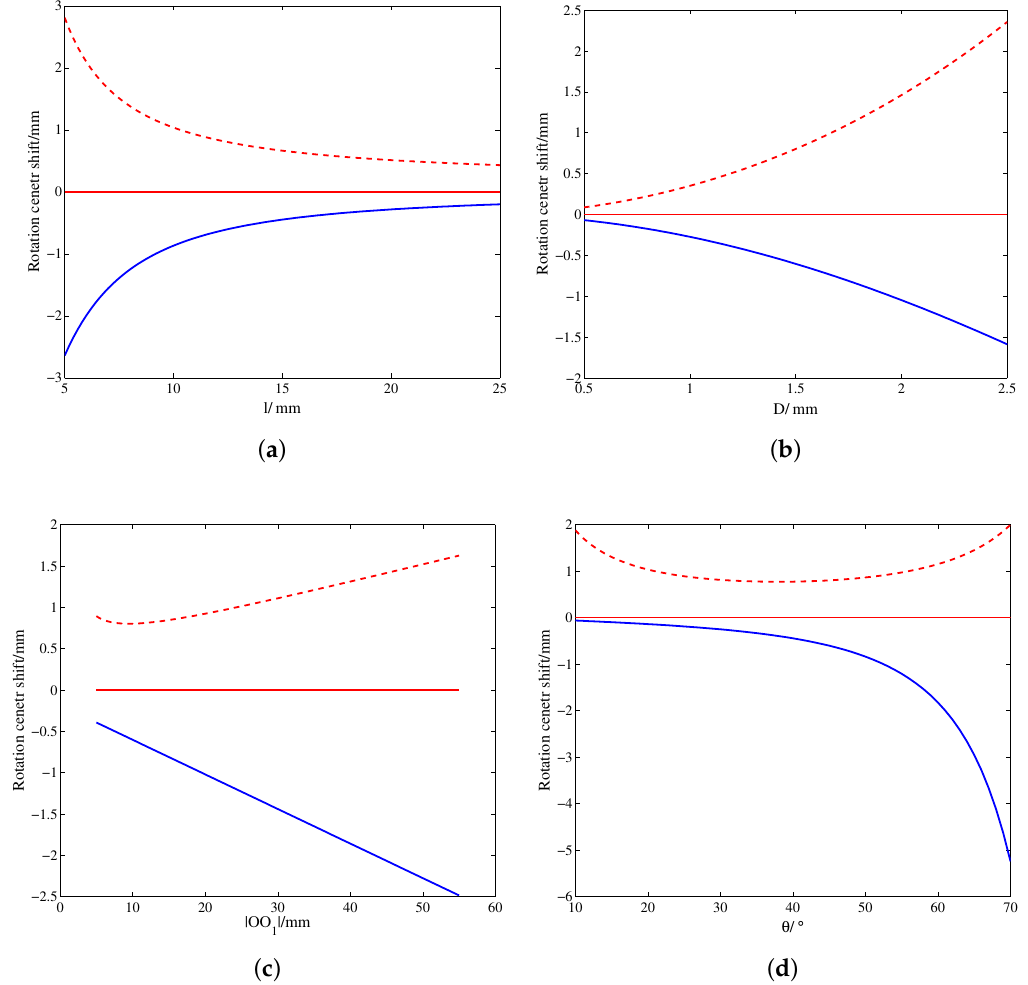
Figure 10. The influences of different RCC mechanism parameters on the center shift (solid—pure moment loading case, dot—direction fixed force loading case. ( a ) influence of l ; ( b ) influence of D ; ( c ) influence of | OO 1 | ; ( d ) influence of θ